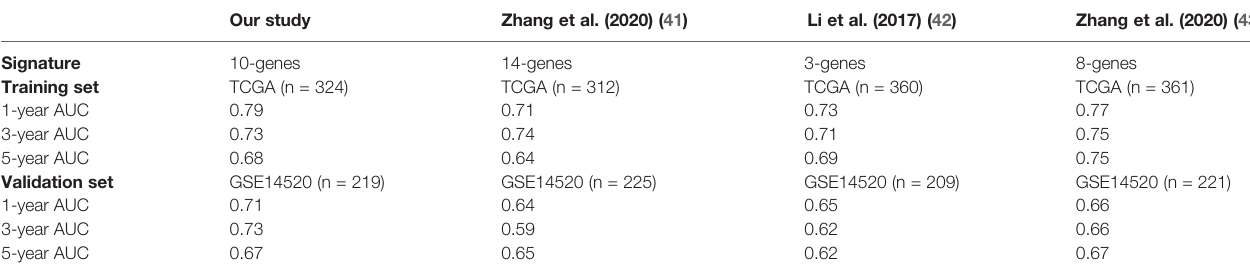
TABLE 1 | Comparison of AUCs for prognostic signatures in different